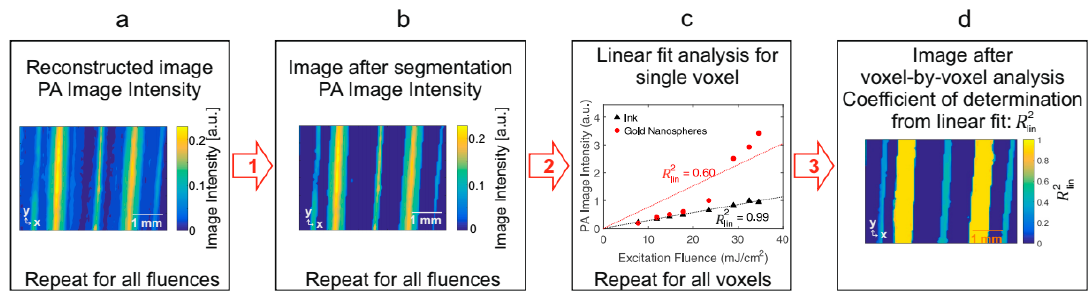
Figure 3. Flow chart of Method I. After image reconstruction ( a ), a linear, fluence ‐ dependent threshold is applied to remove the image background ( b ). ( c ) The fluence ‐ dependent image intensity is extracted from the segmented voxels, which correspond to the location of absorber ‐ filled tubes. A linear function is fitted to the image intensity voxel by voxel, and the coefficient of determination, (cid:1844) (cid:3039)(cid:3036)(cid:3041)(cid:2870) , is plotted in the final image ( d ). All images shown are MIPs.